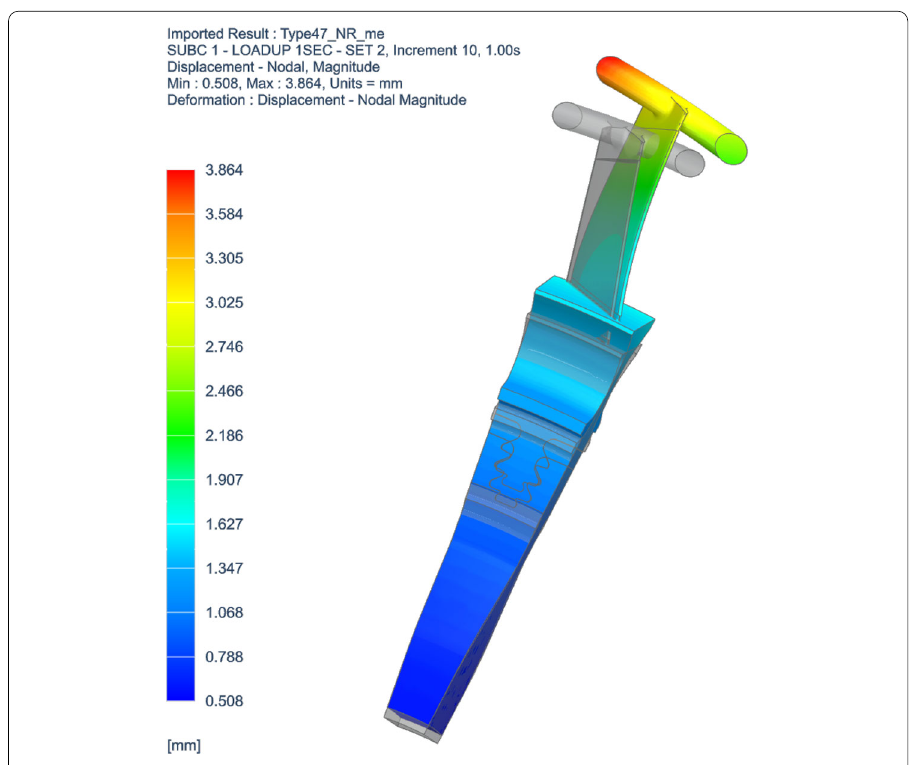
Fig. 5 Initial configuration (gray) and deformed geometry (color) for the most loading time step